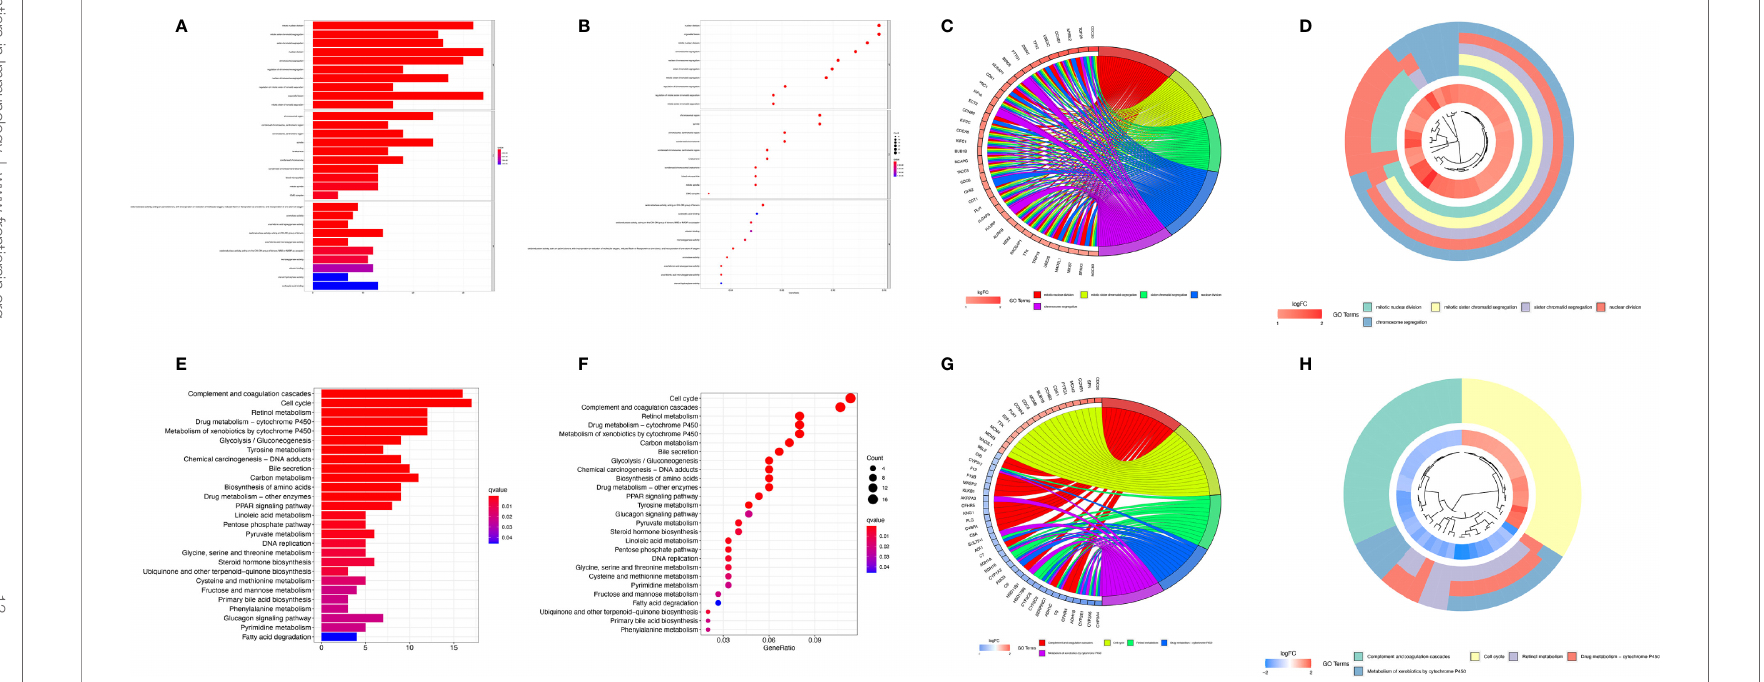
FIGURE 8 | Functional analysis based on differentially expressed genes (DEGs) between the high-risk and low-risk groups from the TCGA-LIHC dataset. The bubble plot (A) , bar plot (B) , circular plot (C) , and cluster plot (D) of the GO pathways enriched for the DEGs between the high-risk and low-risk groups according to the risk score based on macrophage-related clusters. The bubble plot (E) , bar plot (F) , circular plot (G) , and cluster plot (H) of KEGG pathways enriched for the DEGs between the high-risk and low-risk groups according to risk score based on macrophage-related